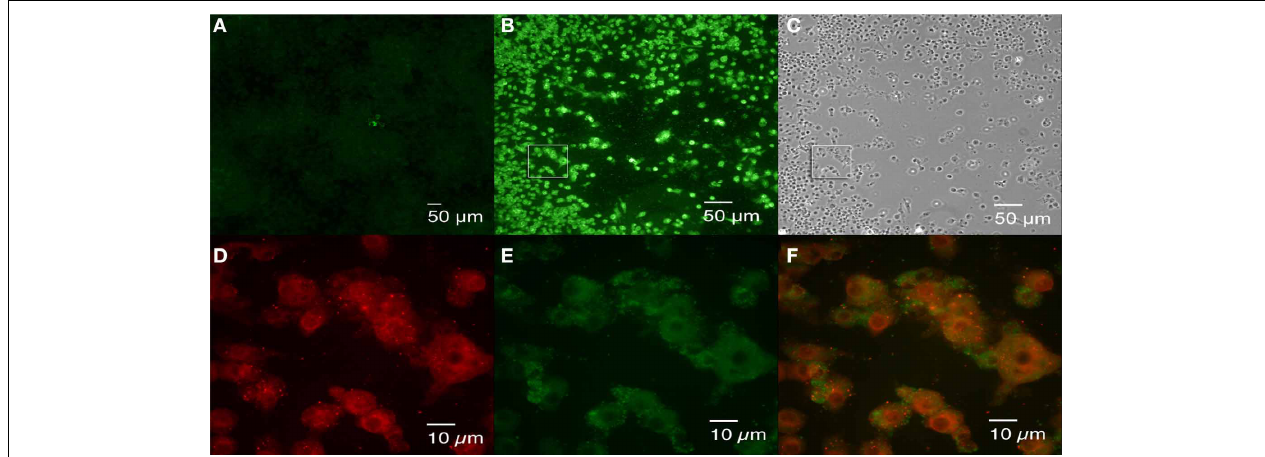
FIGURE 6 | Brucella dissociation detected in large foci following 16M infection. J774.A1 macrophages were infected with 16M at an MOI of 0.1. Agarose overlay and fresh DMEM were added at 1h p.i. and incubation was continued for an additional 4 days. Following fixation in 3.7 % (w/v) formaldehyde, double antibody staining (rabbit mono-specific anti-M serum and goat anti B. ovis serum) was performed as described in the legend to